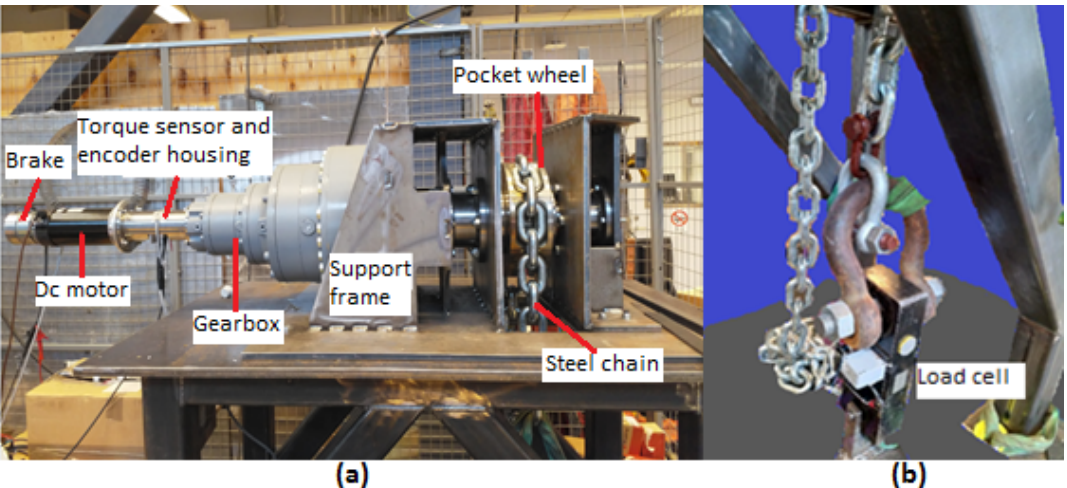
Figure 7. ( a ) The compensator system with the parts labeled in the image. ( b ) The steel chain pulls the load cell.